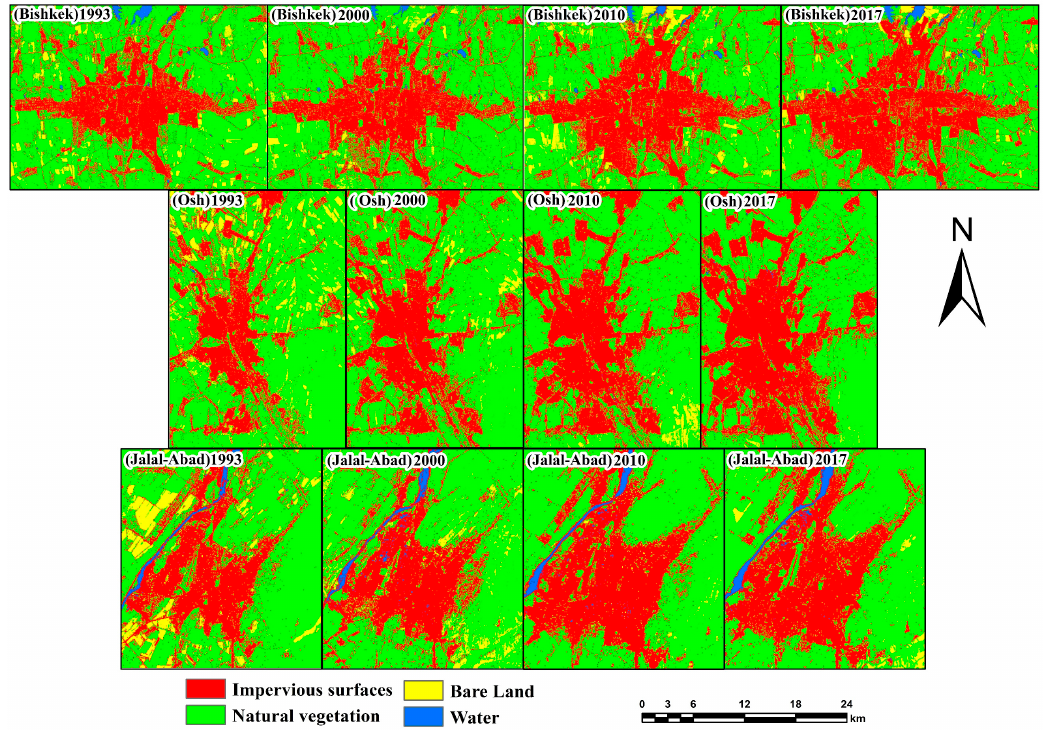
Figure 4. Impervious surface areas for different years.